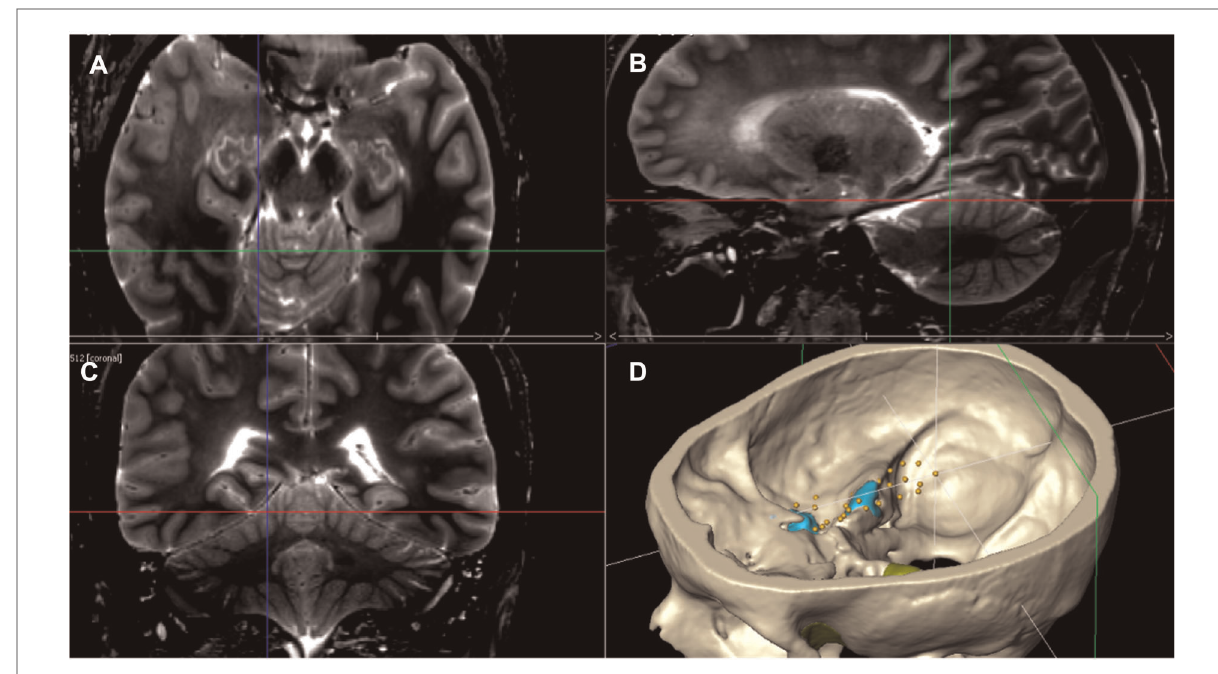
FIGURE 4 Pictures retrieved from neuronavigation axial ( A ), sagittal ( B ), and coronal ( C ) T2 MRI scans of one specimen and from Amira software reconstruction ( D ) of the same specimen indicating the posterior limit of the tentorial cut.